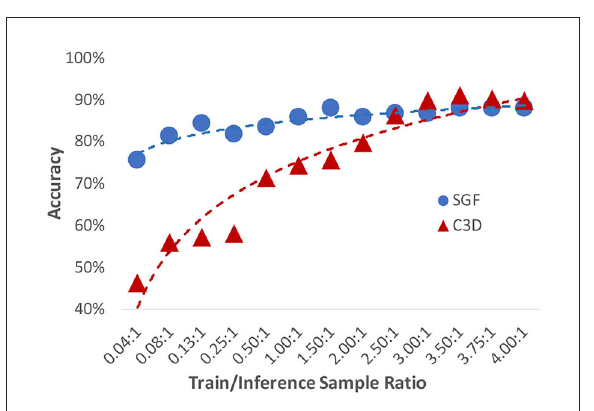
Figure 11B: left wave, right wave, and air drum. The power consumption is 9 mW and memory size is 99 KB, which